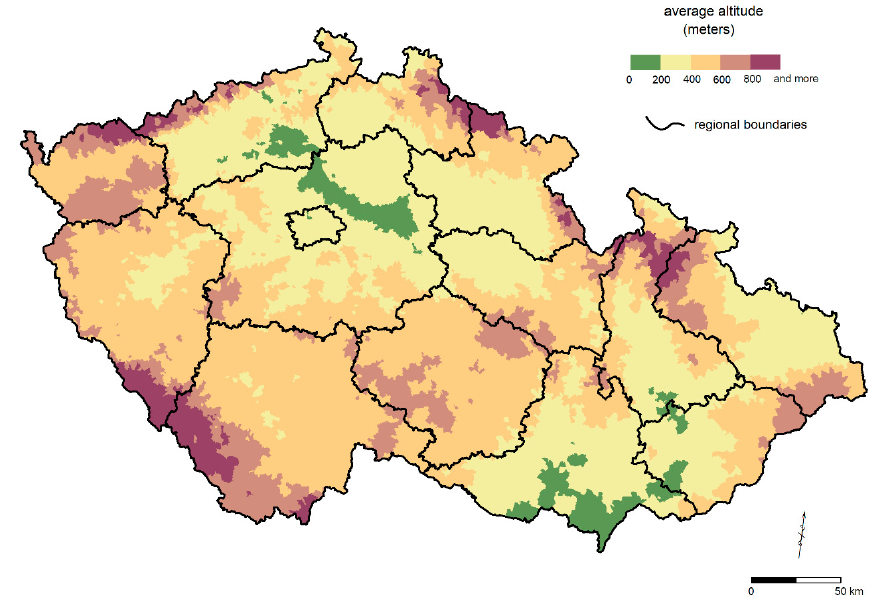
Figure 2. Average altitude in the Basic Territorial Units (BTUs) of Czechia (meters above the sea level (m.a.s.l.)). Source: Arc Č R 500, own calculation.